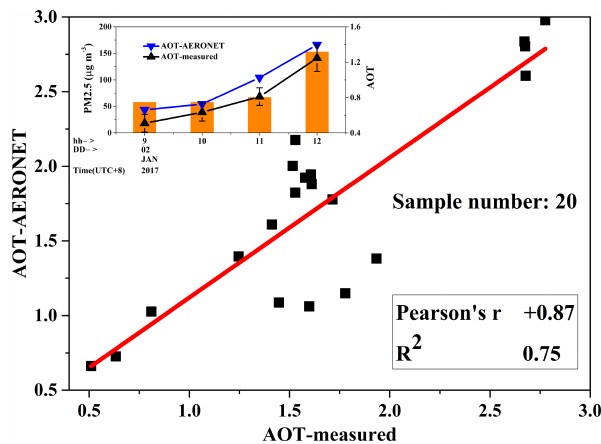
Figure 2. Correlation of the AOT values deduced from AERONET sites and ground-based lidar data. The inserted chart gives the changes of PM 2 . 5 mass concentration and AOT values at the ground-based lidar site on 2 January